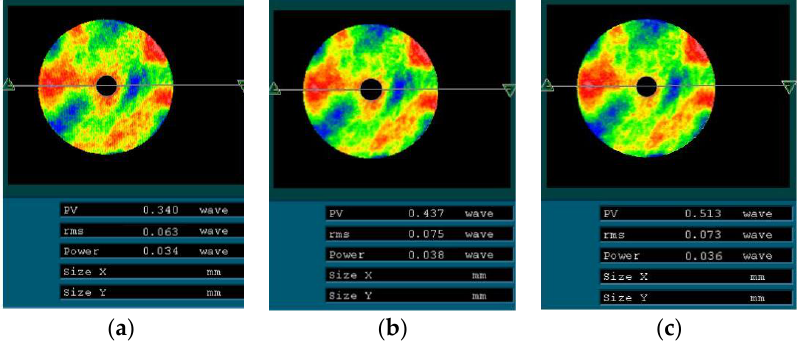
Figure 18. Detection results after multiple adjustments. ( a ) F (0,0), 0.063 𝜆 ( b ) F (0,−0.1), 0.075 𝜆 and ( c ) F (0,0.1) 0.073 𝜆 .